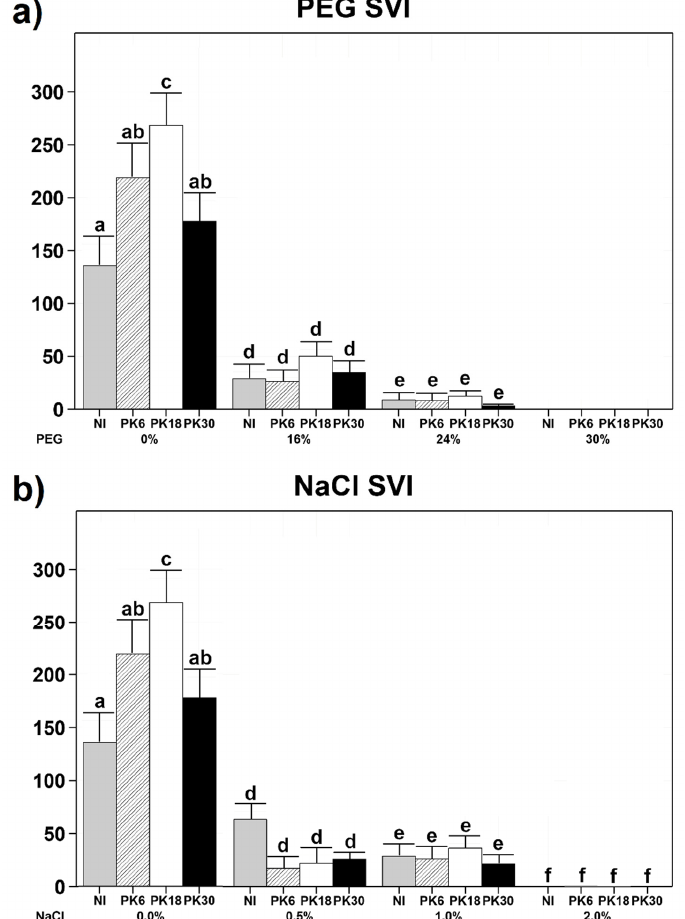
Figure 2. Barplots showing seedling vigor index (SVI) of Triticum durum inoculated or non-inoculated with bacterial strains isolated from olive rhizosphere and germinated for 6 days in the dark under osmotic or salinity stress. NI = non-inoculated. ( a ) Plants germinated at varying PEG concentrations. At 0% PEG, n = 19 non-inoculated, n = 21 PK6-inoculated, n = 23 PK18-inoculated and n = 24 PK30-inoculated. At 16% PEG, n = 6 non-inoculated, n = 7 PK6-inoculated, n = 8 PK18-inoculated and n = 6 PK30-inoculated. At 24% PEG, n = 5 non-inoculated, n = 5 PK6-inoculated, n = 6 PK18-inoculated and n = 6 PK30-inoculated. At 30% PEG, no germination was observed in any of the treatments. ( b ) Plants germinated at varying NaCl concentrations. At 0% NaCl, n = 19 non-inoculated, n = 21 PK6-inoculated, n = 23 PK18-inoculated and n = 24 PK30-inoculated. At 0.5% NaCl, n = 9 non-inoculated, n = 4 PK6-inoculated, n = 4 PK18-inoculated and n = 6 PK30-inoculated. At 1% NaCl, n = 15 non-inoculated, n = 14 PK6-inoculated, n = 15 PK18-inoculated and n = 15 PK30-inoculated. At 2% NaCl, n = 6 non-inoculated, n = 9 PK6-inoculated, n = 10 PK18-inoculated and n = 6 PK30-inoculated. Means + standard errors are presented. Different letters above bars represent significant differences ( p < 0.05) among treatments according to Tukey’s HSD outcomes.